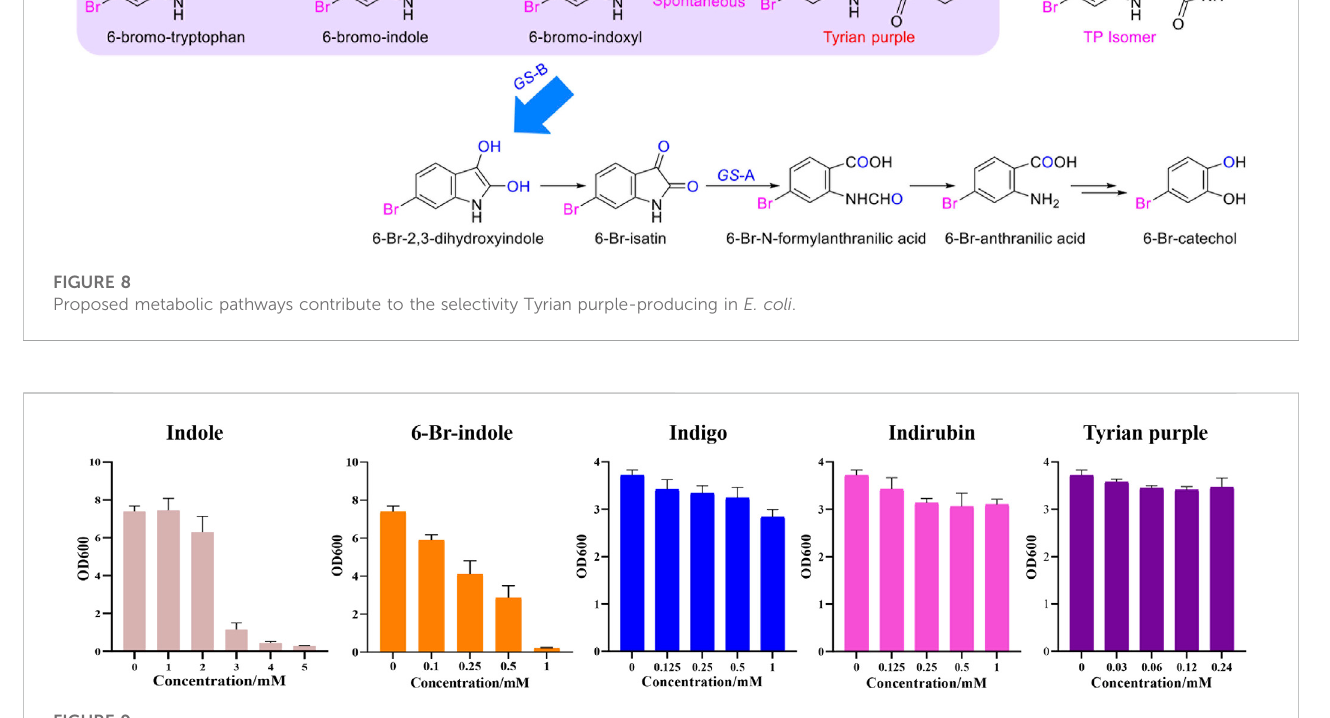
FIGURE 9 Effect of indole, 6-Br-indole, indigo, indirubin, and Tyrian purple on the growth of E. coli.